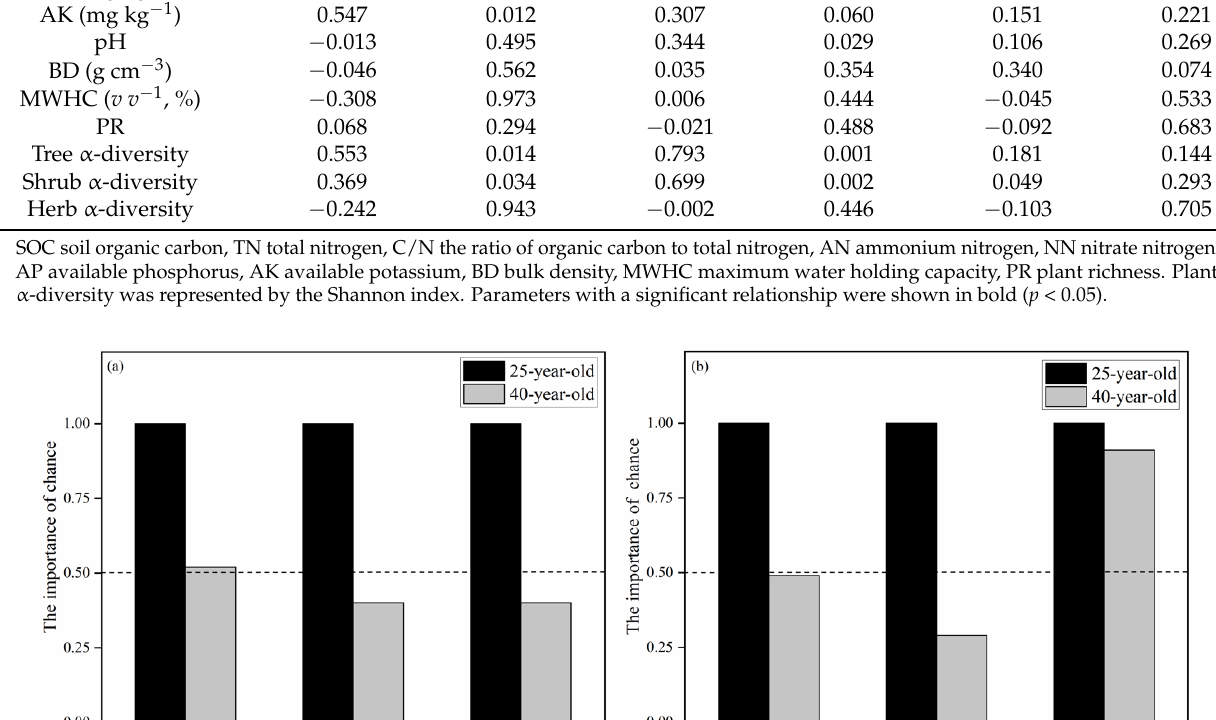
Figure 4. The relative importance of chance effect in the structure ( a ) and funtion ( b ) of bacterial, fungal and archaeal communities.